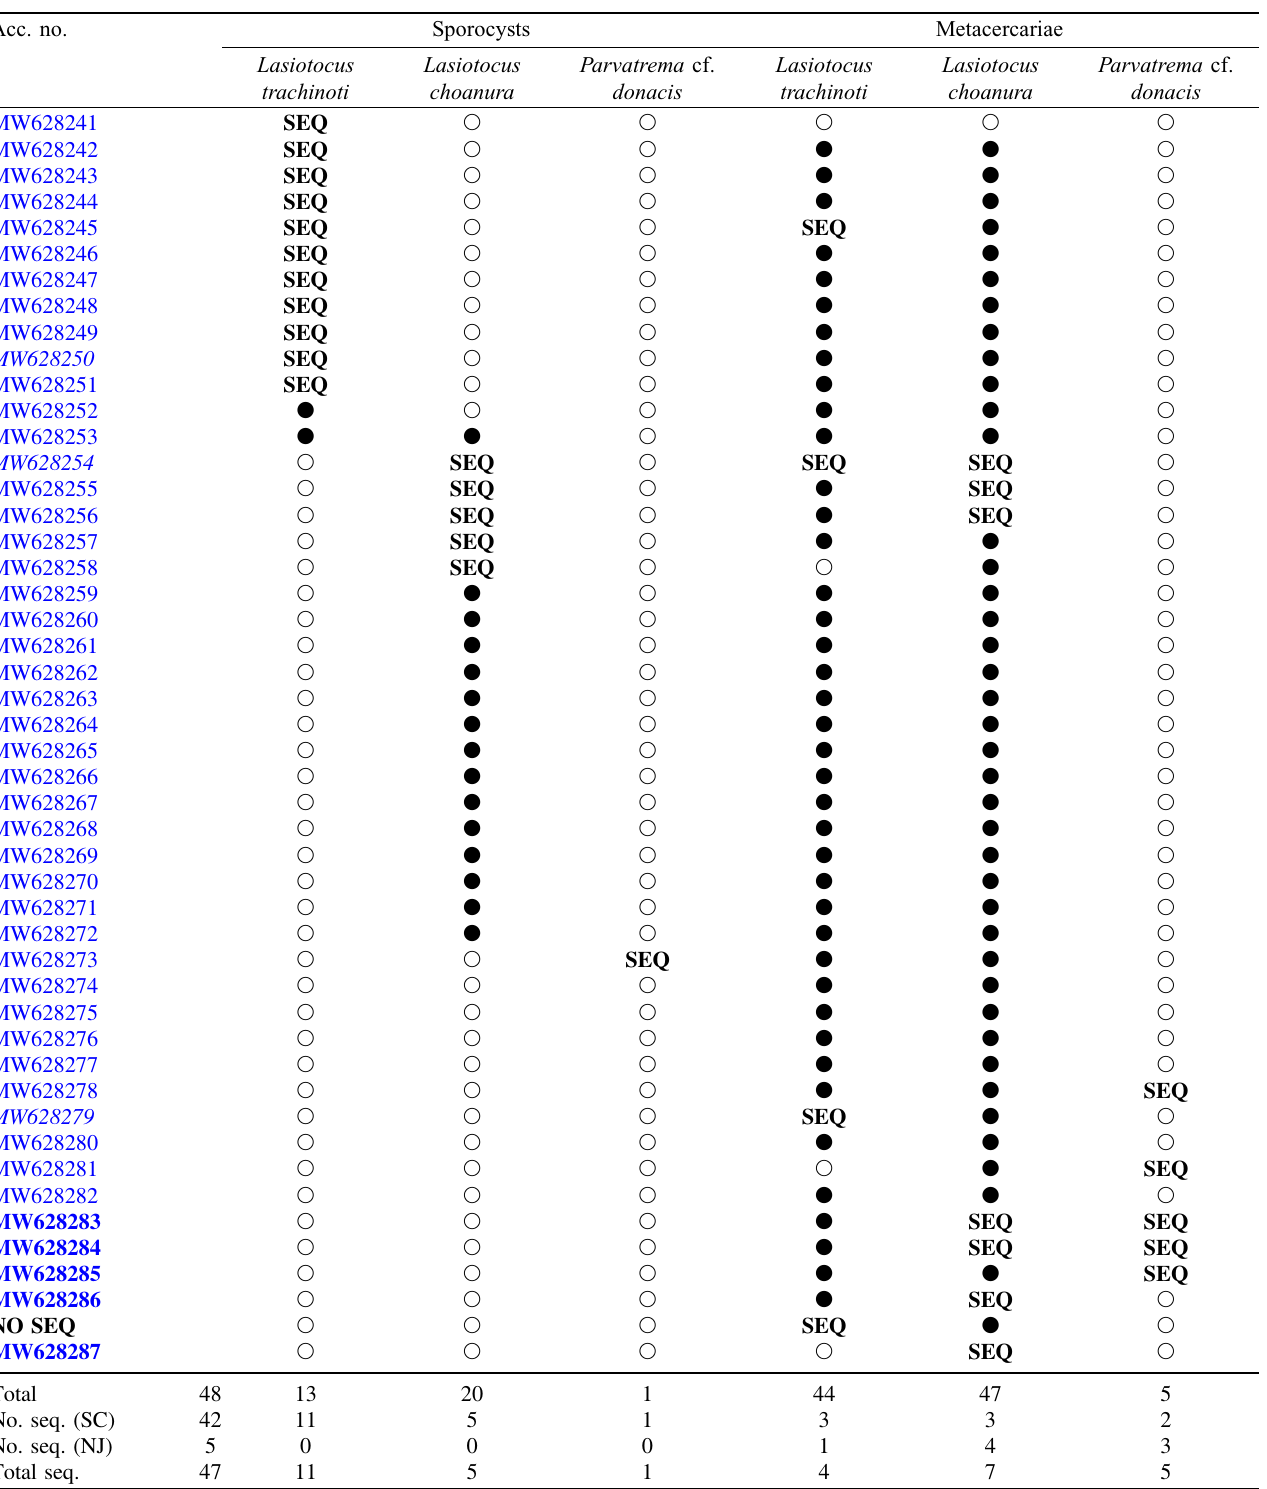
Table 2. GenBank accession numbers (acc. no.) of cytochrome c oxidase I mitochondrial DNA sequences from individuals of Donax fossor infected by sporocysts and/or metacercariae of Lasiotocus trachinoti , L. choanura , and Parvatrema cf. donacis collected from South Carolina (SC) and New Jersey (NJ, in bold), USA from June through October between 2018 and 2020. Acc.